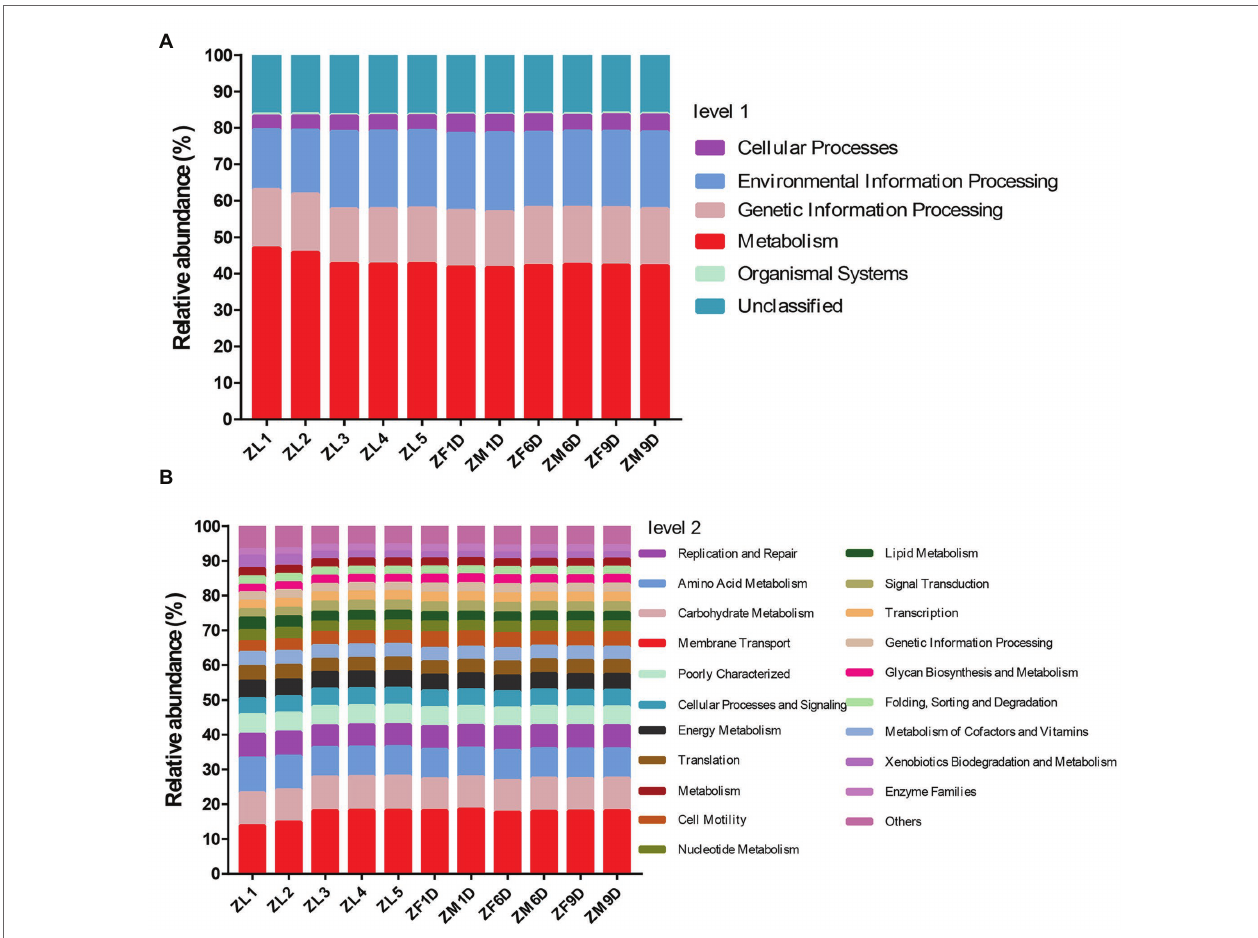
FIGURE 3 | Prediction of functional pathway abundance at different developmental stages. (A) Function prediction based on Level 1. (B) Function prediction based on Level 2. In level 2, pathways ranked below 20 in total relative abundance were classified as